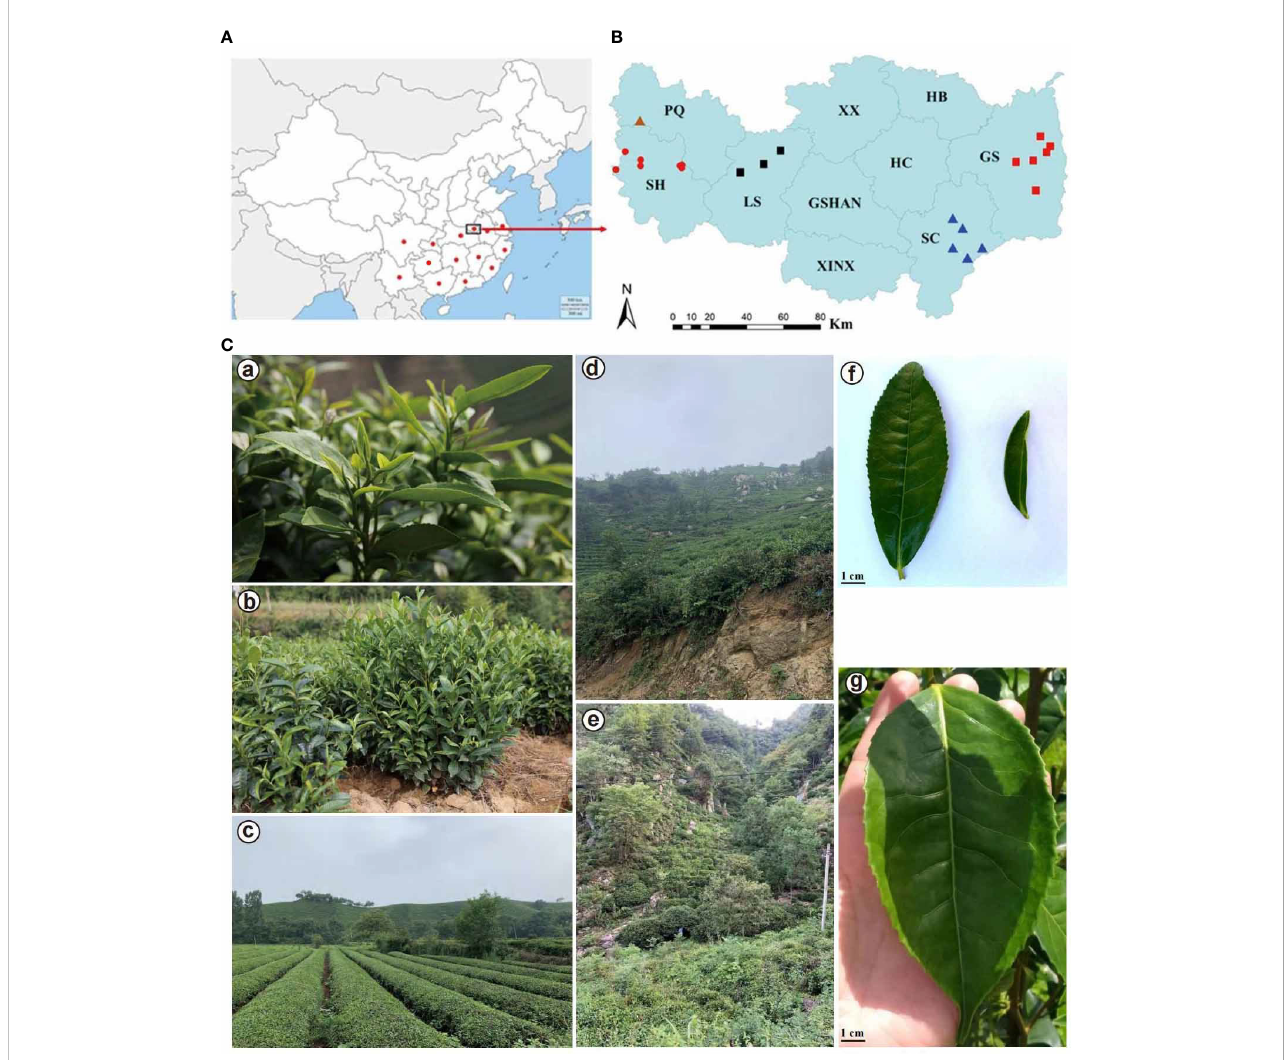
FIGURE 1 Geographical distribution of 94 Camellia accessions, leaf morphology and habitat of the Xinyang Maojian tea population. (A) Geographical distribution of 94 Camellia samples. Red dots indicate Camellia samples in different provinces of China. (B) Geographical distribution of 59 Camellia sinensis var. sinensis from central China, Xinyang city, Henan province. PQ, Pingqiao District; SH, Shihe District; LS, Luoshan County; XX, Xi County; GSHAN, Guangshan County; XINX, Xin County; HB, Huaibin County; HC, Huangchuan County; GS, Gushi County; SC, Shangcheng County. Dots with the same shapes indicate the same sampling location. (C) Leaf morphology and habitat of the Xinyang Maojian tea populations. (a) Leaf morphology of the Xinyang Maojian tea population. (b) The close-up view of the tree or shrub life-form of Xinyang Maojian tea population. (c, d) indicate the habitat of